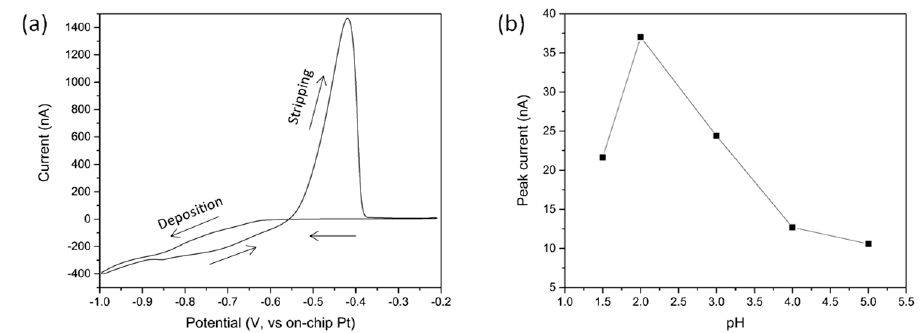
Figure 5. ( a ) Cyclic Voltammogramm of copper electrodeposition onto the Pt microbands (10 mM CuSO 4 , pH 2); ( b ) Influence of the pH of the solution on measured stripping current (100 µ g/L CuSO 4 solution, 300 s deposition at − 0.65 V). The line is a guide to the eye only. The influence of the solution pH on the peak stripping current response was studied by varying solution pH from 5 to 1 (100 µ g/L CuSO 4 solution, deposition at − 0.65 V for 300 s), see Figure 5b. Decreasing the pH led to a change in the measured stripping current with the maximum stripping peak current found at pH 2. This optimal pH value was thus selected as the pH of choice for further